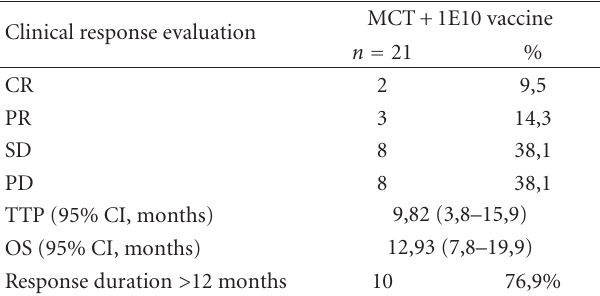
Table 3: E ffi cacy evaluation after the treatment of MBC patients with MCT combined with 1E10 Aluminum/hydroxide